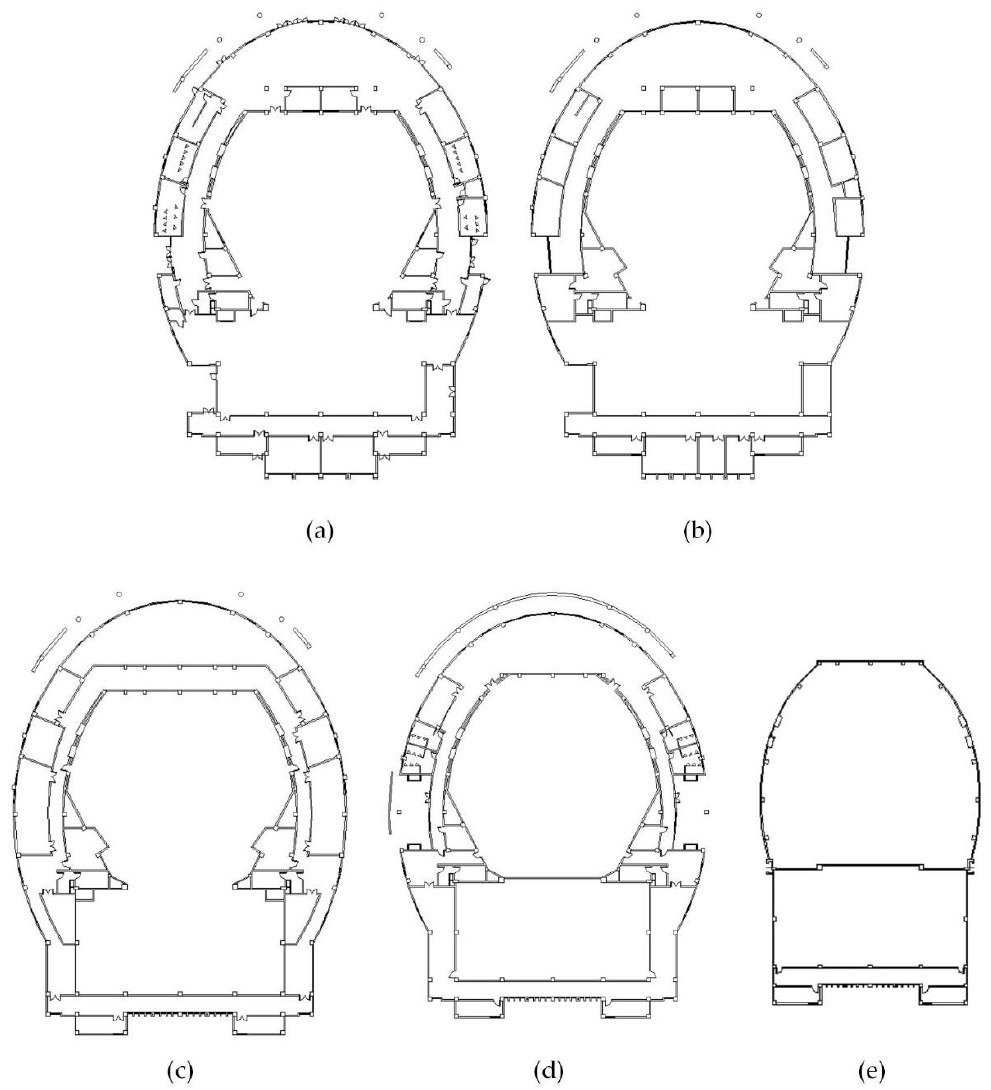
Figure 16. Floor plans of the building: ( a ) first floor, ( b ) second floor, ( c ) third floor, ( d ) fourth floor, and ( e ) fifth floor.